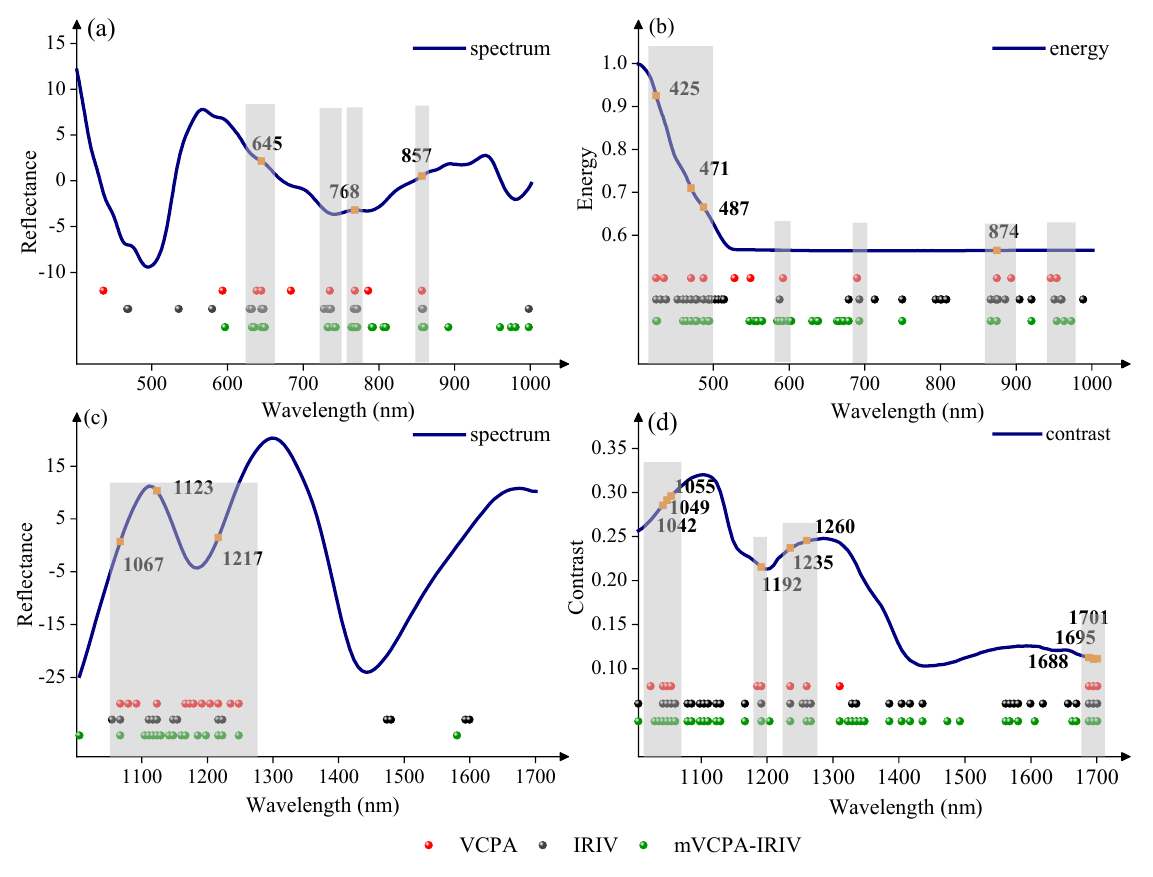
Figure 7. The distribution of key wavelengths selected by different variable selection algorithms from spectra and texture data of Vis-SWNIR and LWNIR regions, respectively. ( a ) Spectrum in Vis-SWNIR region, ( b ) energy parameters in Vis-SWNIR region, ( c ) spectrum in LWNIR region, and ( d ) contrast parameters in LWNIR region. Note: red points, black points, and green points represent the variables retained by VCPA, IRIV, and mVCPA-IRIV in the spectrum or texture parameters, respectively. Orange points represent the bands jointly selected by all three algorithms. Table 5. The classification results of the feature-level fusion of spectral and texture